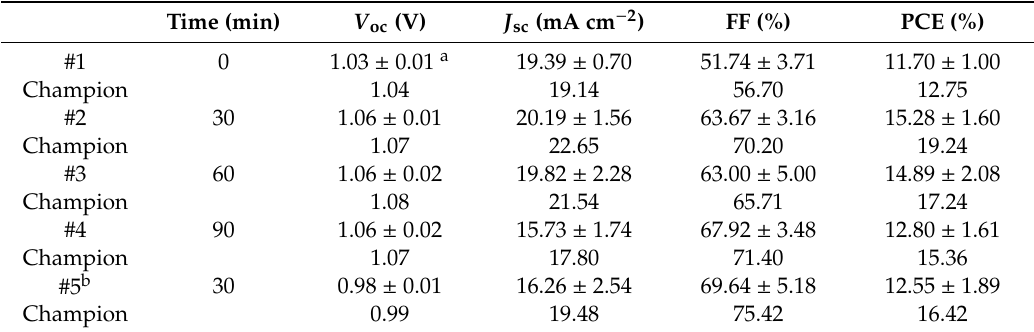
Table 2. Photovoltaic parameters of the assembled planar PSCs with a typical configuration of FTO / TiO 2 / MAPbI 3 / Spiro-MeOTAD / Ag.